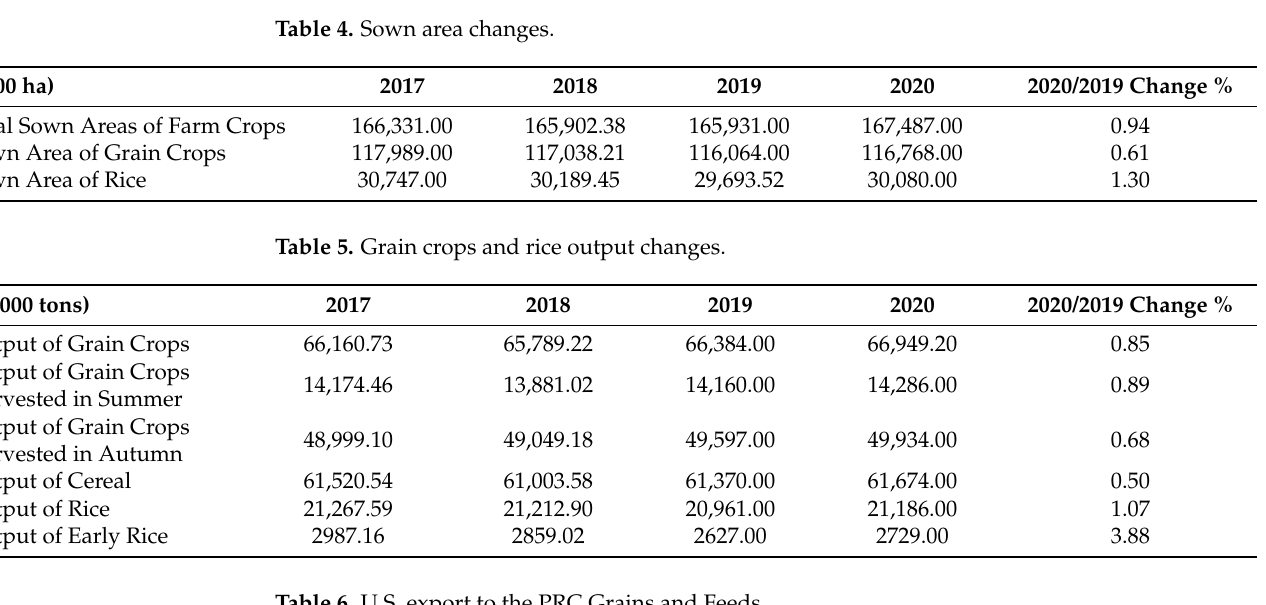
Table 6. U.S. export to the PRC Grains and